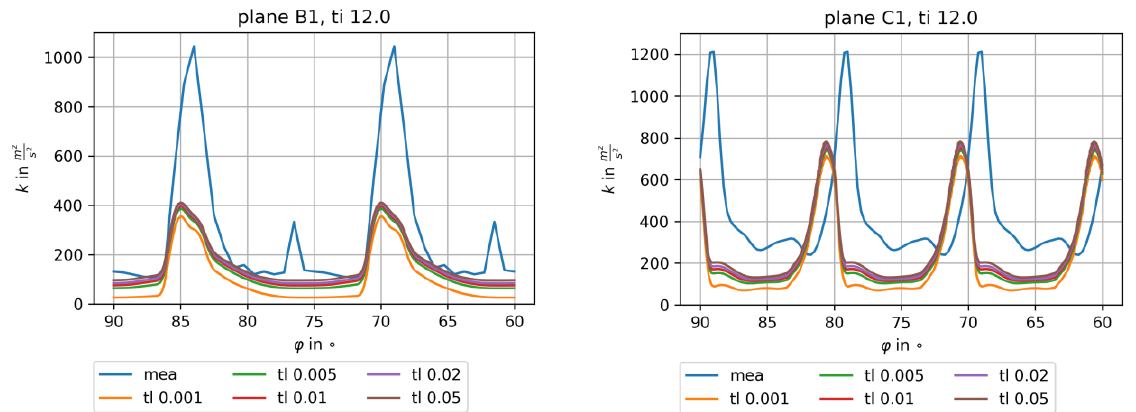
Figure 4. Comparison of turbulence kinetic energy in planes B1 ( left ) and C1 ( right ) for an inlet turbulence intensity of 12% and varying turbulence length scale (1–50 mm) (mea … measured) (Q3D simulation at mid-section).